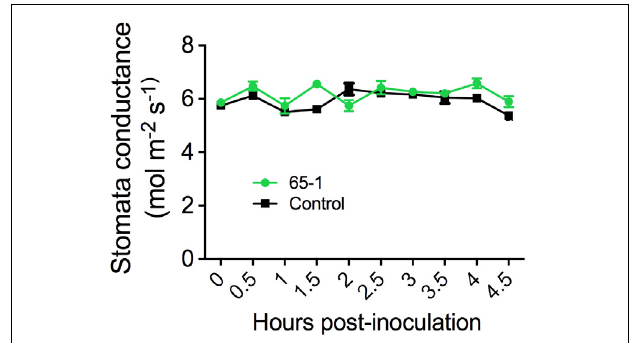
FIGURE 3 | Stomatal conductance of the transgenic line 61-5 and the control. The assessment was done every 30 min after spray inoculation with Pst J4. Data represent the mean of five biological replicates with